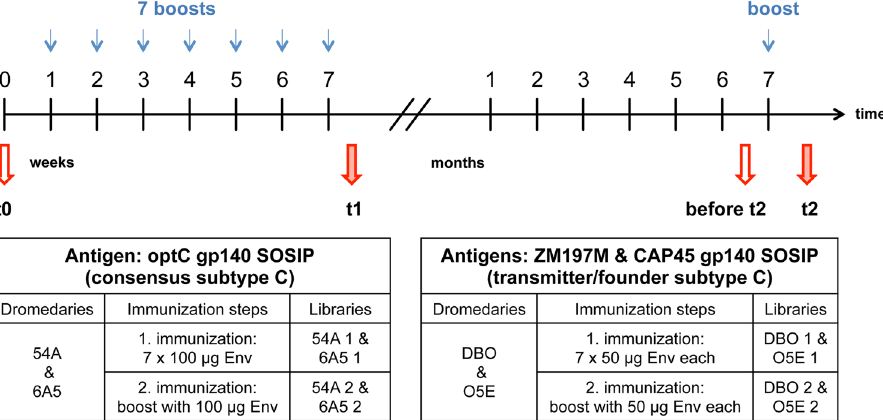
Figure 2. Immunization schedule of dromedaries with subtype C SOSIPs. Animals 54A and 6A5 received optC SOSIP, whereas DBO and O5E received a mixture of ZM197M and CAP45 SOSIPs. The first immunization cycle consisted of 7 weekly protein boosts followed by an additional boost seven months later. Red arrows indicate the timepoints of serum samples used for neutralization assays. Blood samples from timepoints t1 and t2 were also used for the generation of phage displayed nanobody libraries for all 4